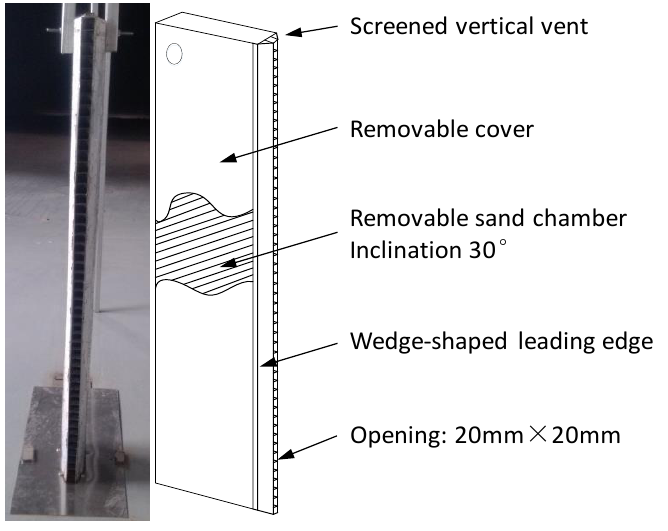
Figure 2. The sand sampler.